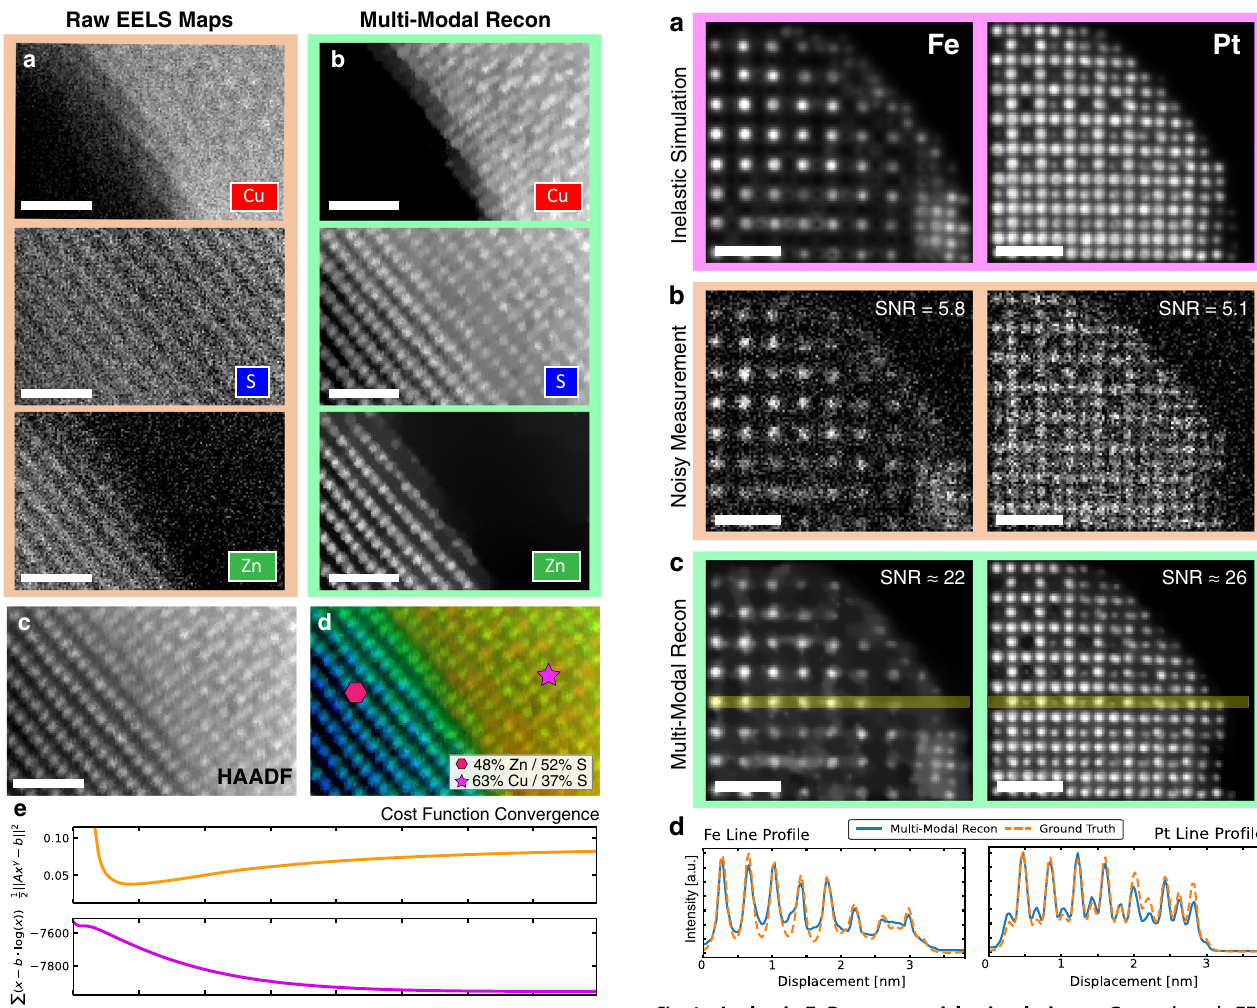
Fig. 4 Inelastic FePt nanoparticle simulation. a Ground truth EELS images generated from inelastic simulations. b EELS maps degraded with Poisson shot noise. SNR is shown on the top right. c Recovered atomic-resolution EELS maps for the Fe and Pt distributions. Estimated SNR is shown on the top right. d Line pro fi les of the marked yellow bars (10 pixels in width) in ( c ) compares the multi- modal reconstruction and ground truth. Scale bar, 1